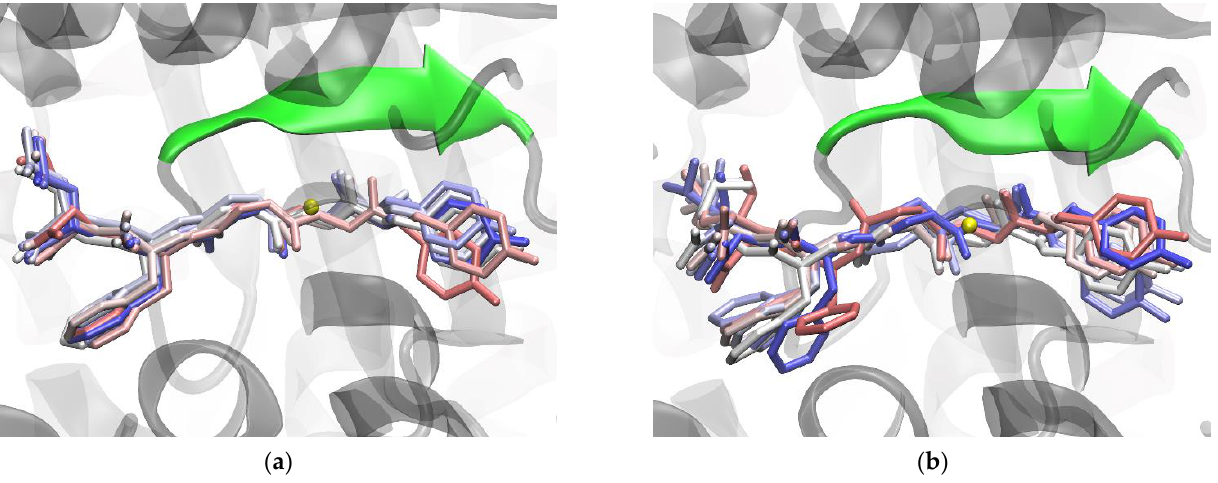
Figure 7. Binding of Leu-enkephalin with the wild-type ( a ) and the R399A mutant ( b ) DPP III - structures obtained after 1 µ s of MD simulations. The Leu-enkephalin structures sampled every 100 ns